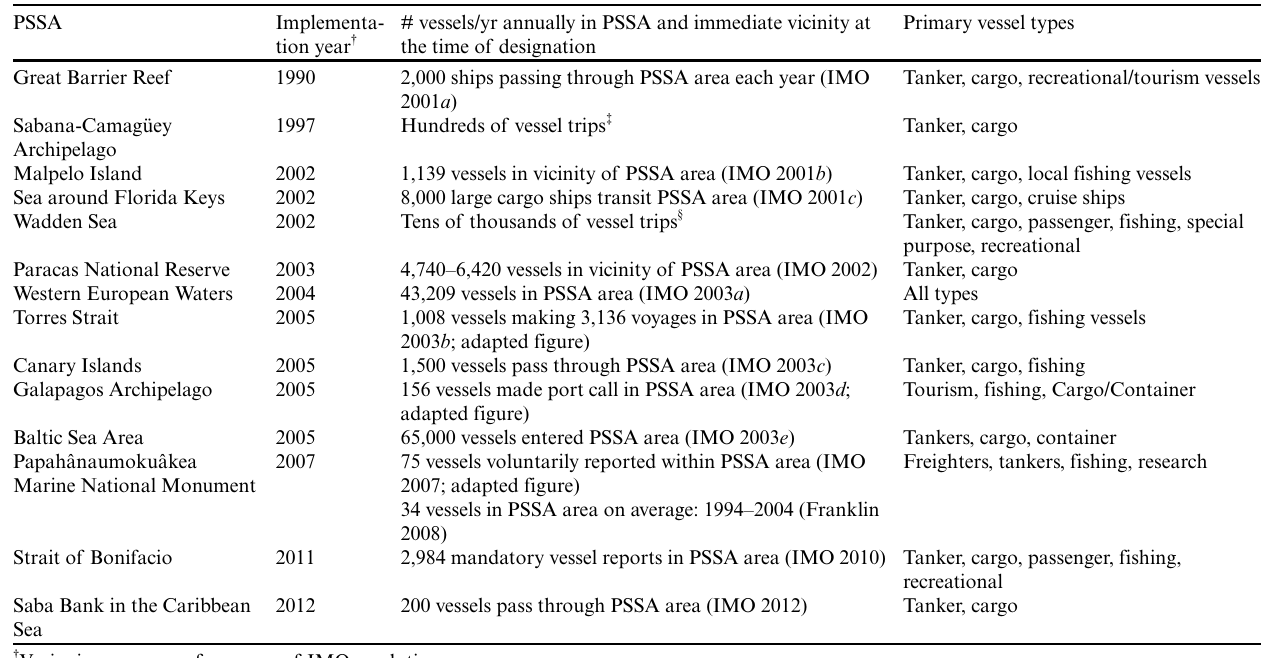
Table 2 . Vessel usage in the PSSA prior to designation by the